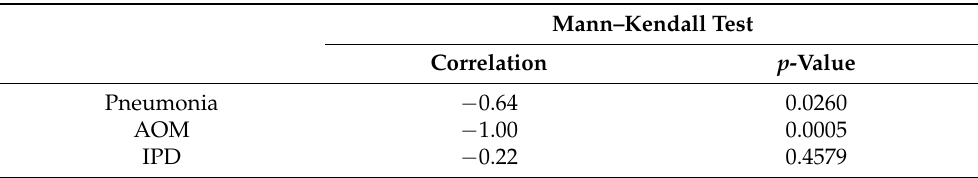
Table 3. Mann–Kendall analysis of annual IR of pneumonia, AOM, and IPD and syndromic diseases for children < 15 years of age.